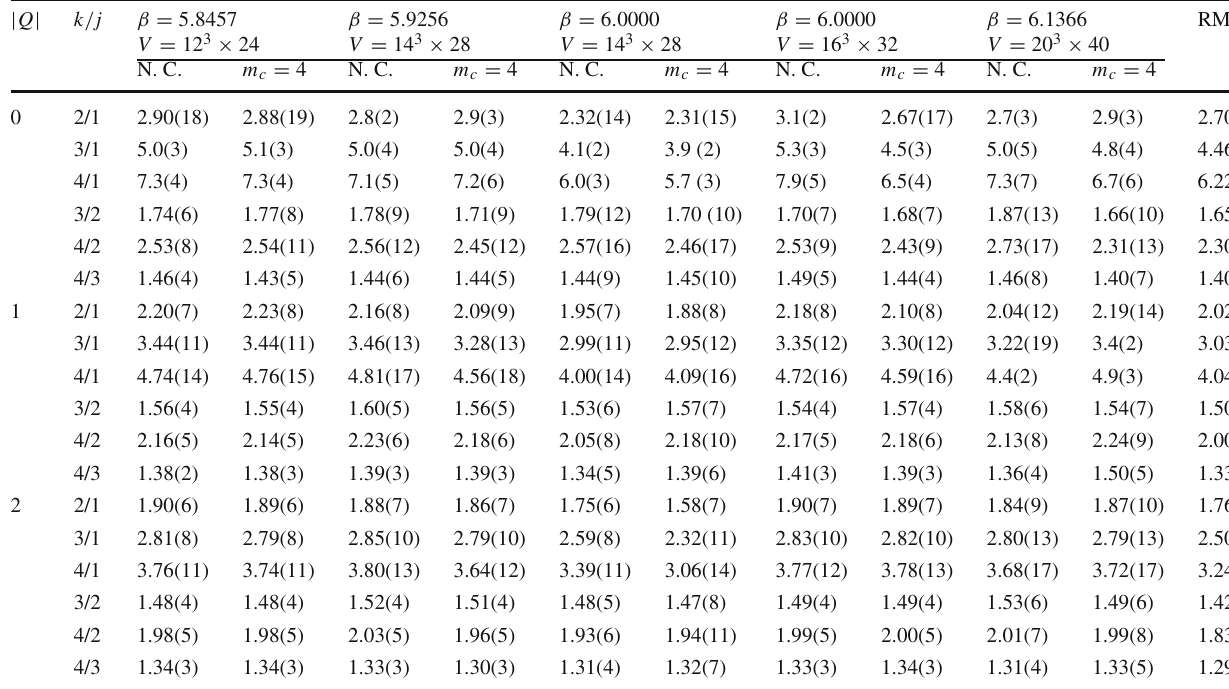
Table 9 Comparing the numerical results of charges m c = 4 are used. The prediction of the chRMT is presented in [59, Table